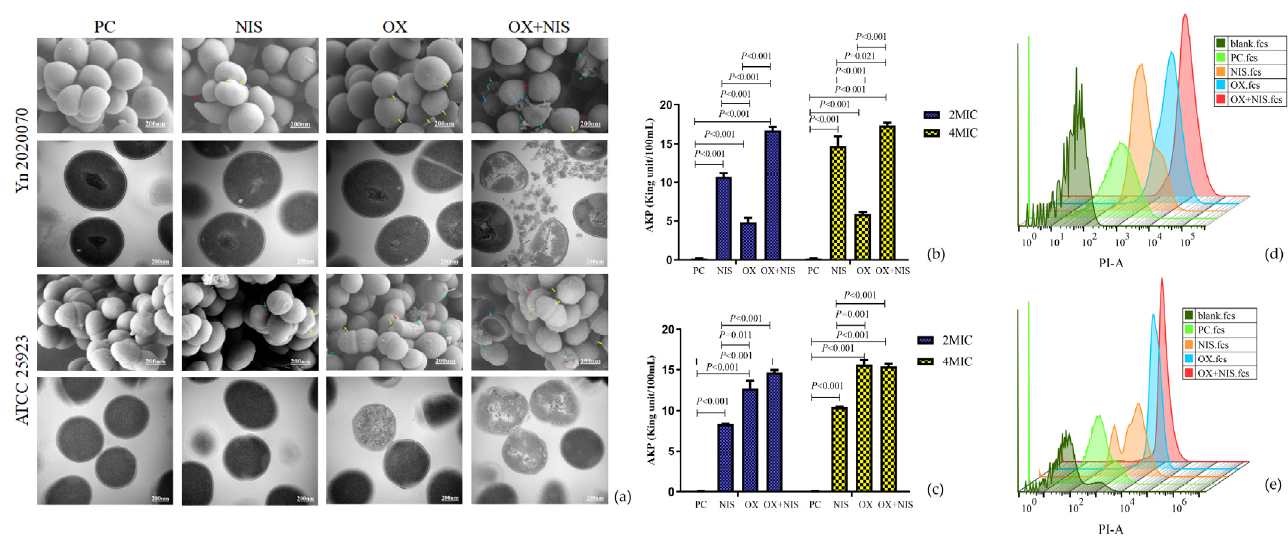
Figure 4. ( a ) Microscopic observation of MRSA Yn2020070 (line 1, 2) and MSSA ATCC25923 (line 3, 4) cells morphological changes treated with PC (column 1), NIS (column 2), OX (column 3) and OX + NIS (column 4) under SEM (line 1, 3) and TEM (line 2, 4). The small arrows indicated the cell damages; And AKP activity of MRSA Yn2020070 ( b ), ATCC25923 ( c ) under OX, NIS and OX + NIS; the cell membranes integrity of MRSA Yn2020070 ( d ), ATCC25923 ( e ) under OX, NIS and OX + NIS,